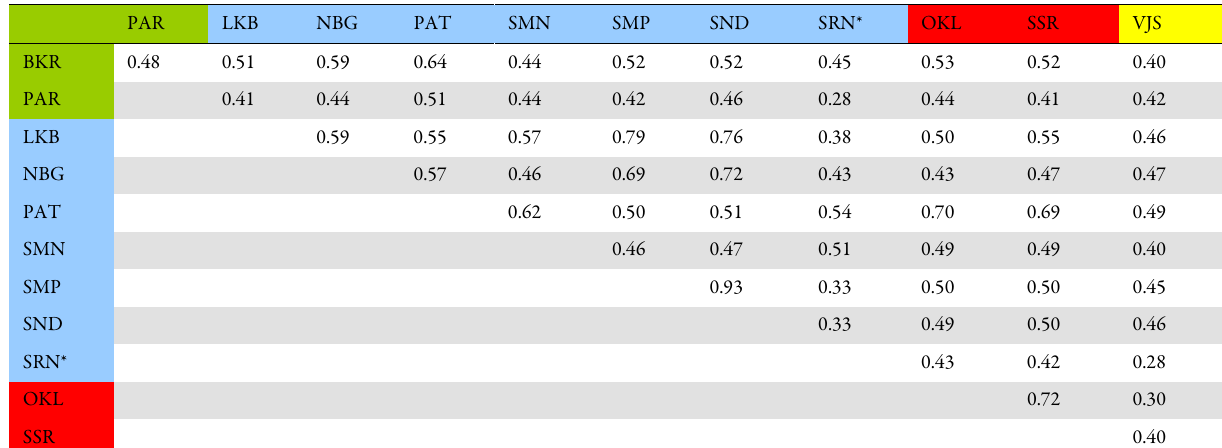
Table 2. Similarity index of Sorensen for wetlands (color bar indicates wetlands from similar ecozones)